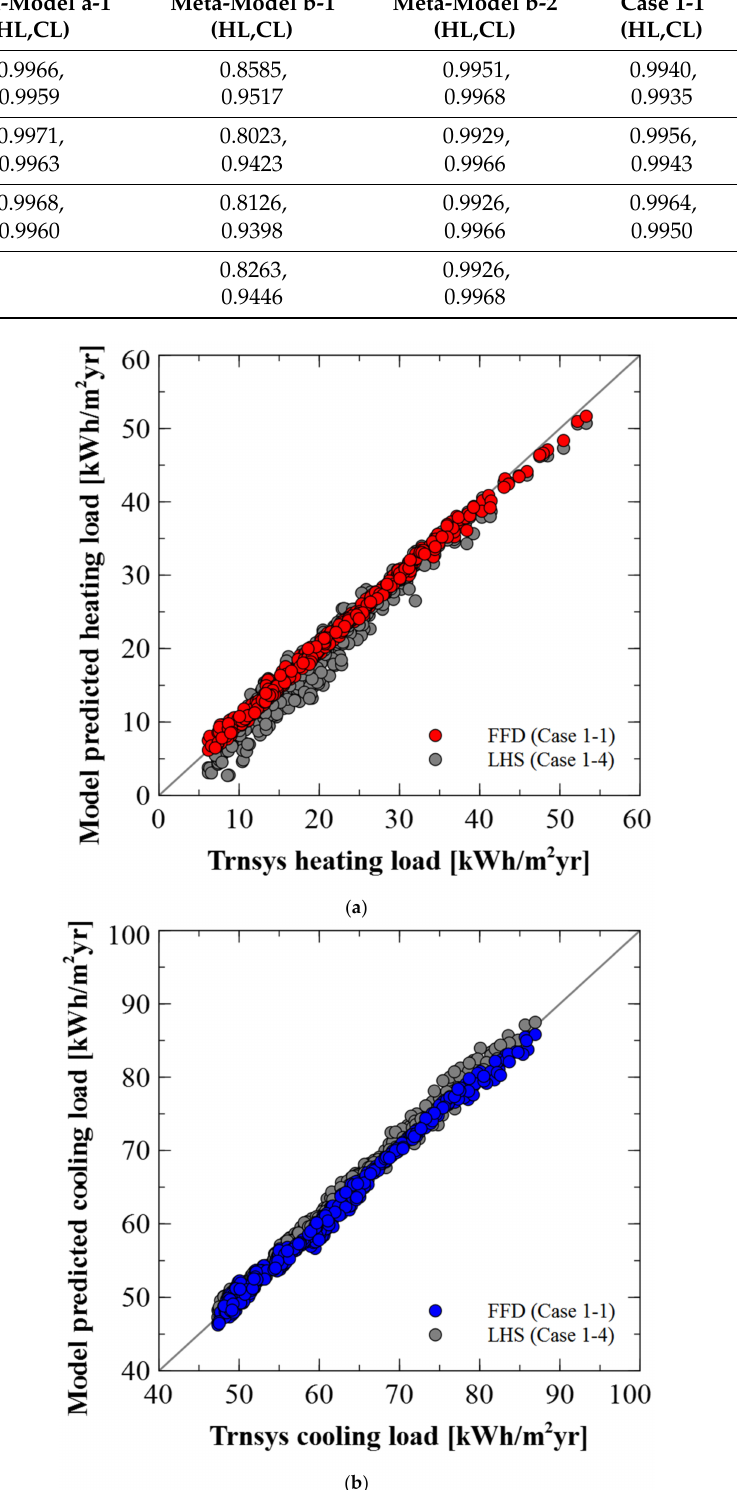
Figure 5. ( a ) Comparison of building heating load prediction accuracy for the “FFD validation set” using LHS and FFD (sampling number: 512). ( b ) Comparison of building cooling load prediction accuracy for the “FFD validation” set using LHS and FFD (sampling number: